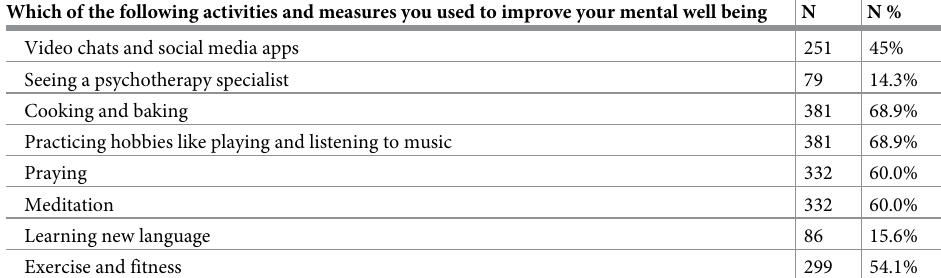
Table 3. Activities and measures used by the participants to improve mental wellbeing. Which of the following activities and measures you used to improve your mental well being N